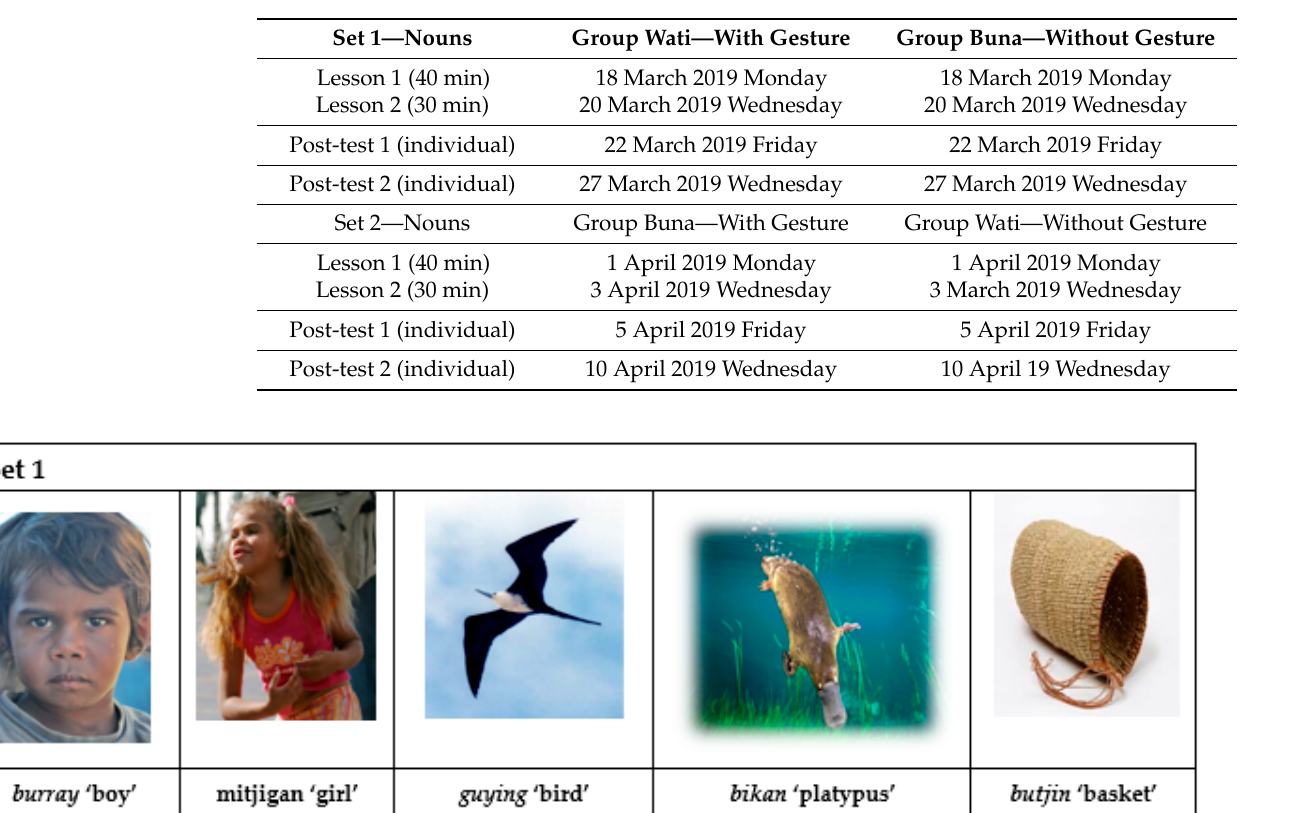
Table 2. Teaching program.